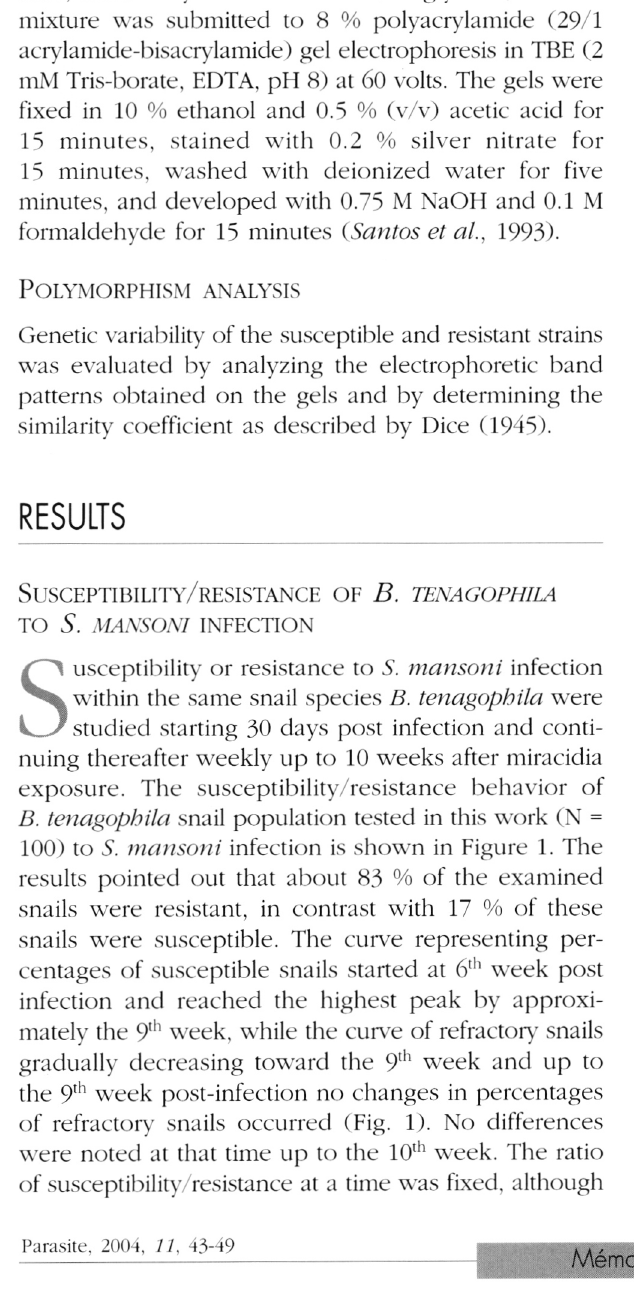
Table I. - Primers used in the RAPD-PCR reactions.